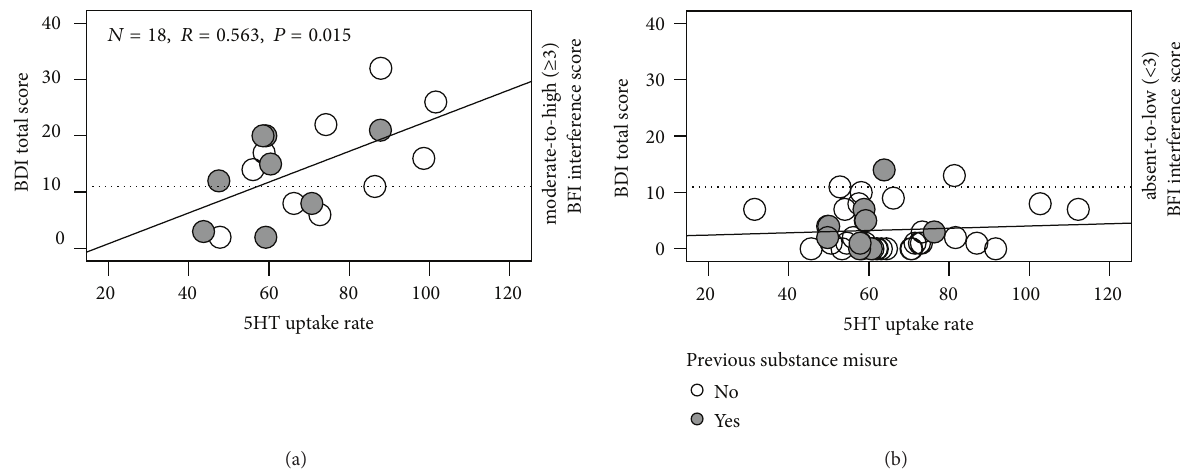
Figure 4: Relationship between the BDI total score and platelet 5HT uptake rate in patients with differed degrees of fatigue interference with mood and activity. Note: the dotted line indicates the cutoff for classification of BDI scores into depressed and nondepressed.